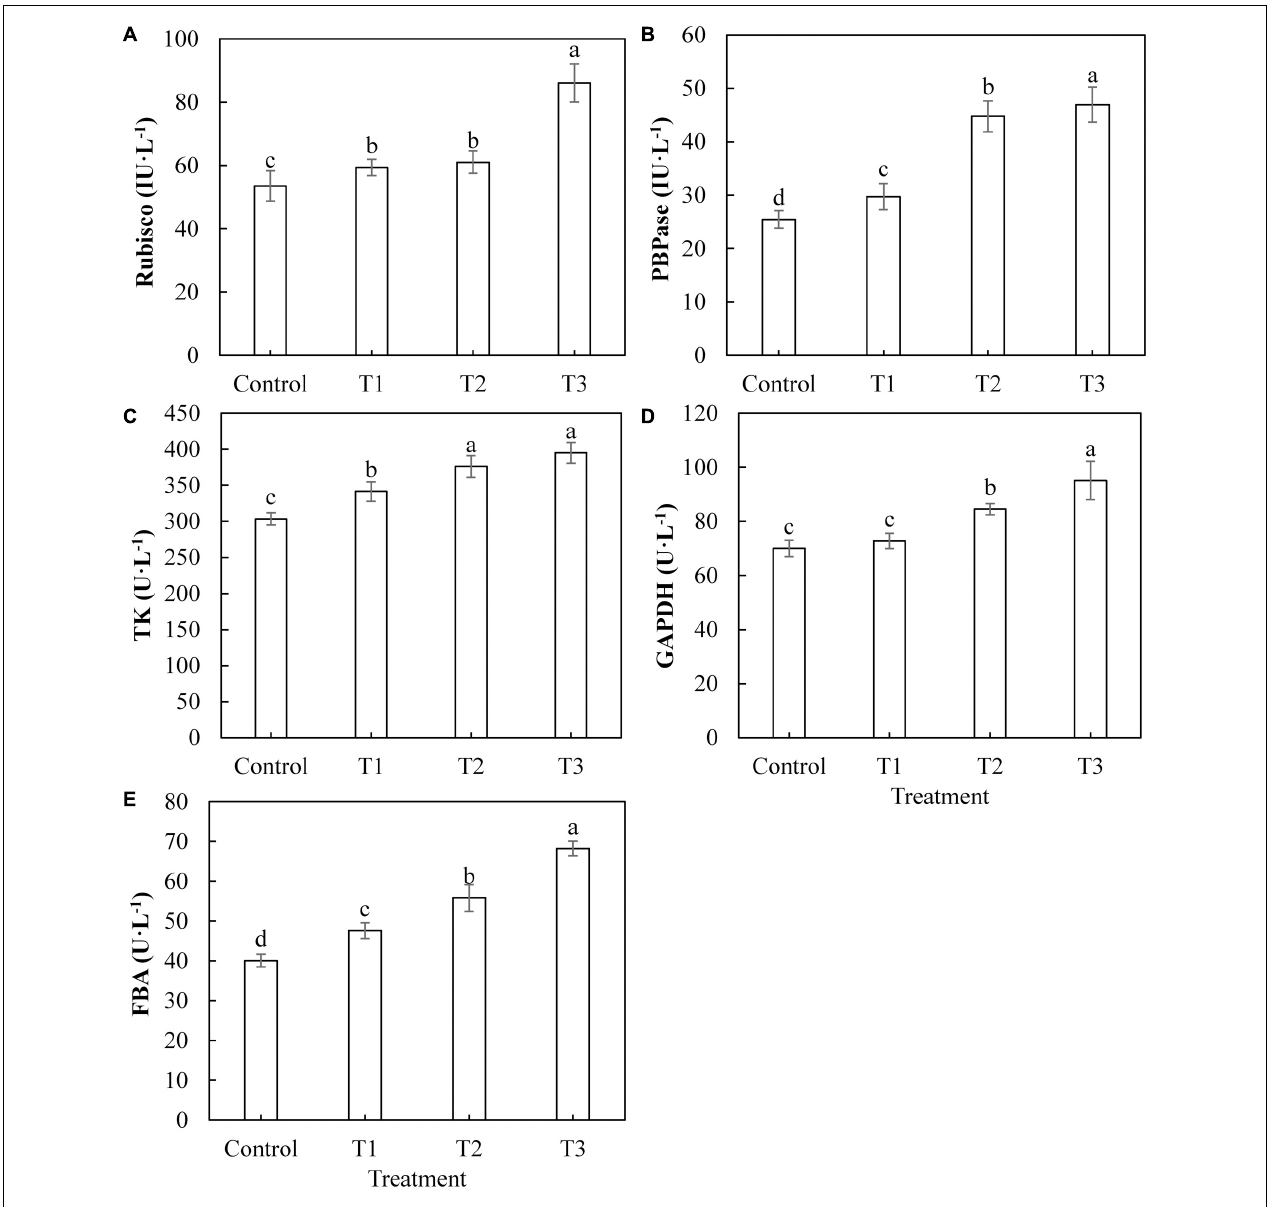
FIGURE 6 | Effects of supplemental LED light duration on the activities of key enzymes of Calvin cycle: ribulose diphosphate carboxylase/oxygenase (A) , fructose-1,6-bisphosphonate (B) , transketolase (C) , glyceraldehyde-3-phosphate dehydrogenase (D) , and fructose-1, 6-bisphosphate aldolase (E) in cucumber leaves. After LED light supplement treatment for 30 days, 10 pieces of the third leaf from the top of cucumber were selected from each treatment, washed and dried immediately, and then put into liquid nitrogen to prepare for the determination of activities of the key enzymes in the Calvin cycle. Values are expressed as mean ± SE ( n = 3). Bars that are significantly different based on the Duncan’s multiple range test ( p < 0.05) are indicated with different lowercase